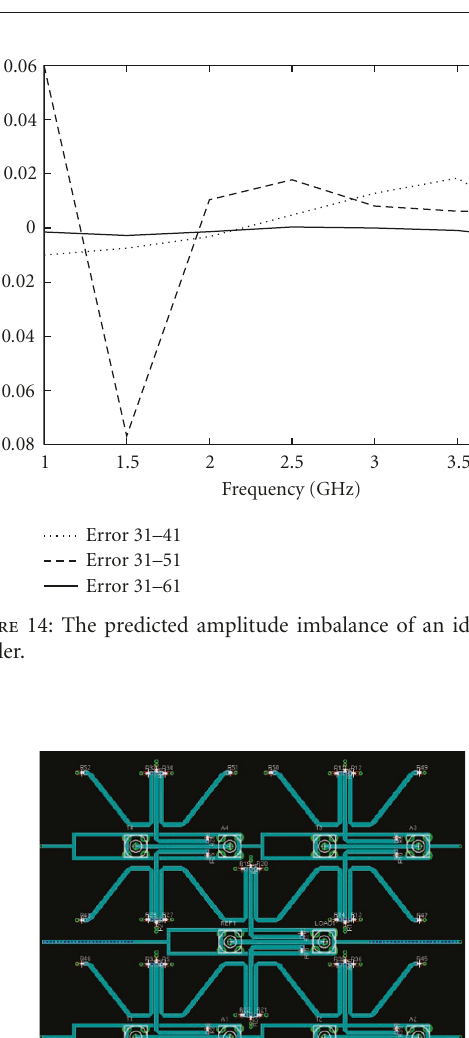
A , D ( X , Z ) type error and an A , C ( X , Y ) type error. This has